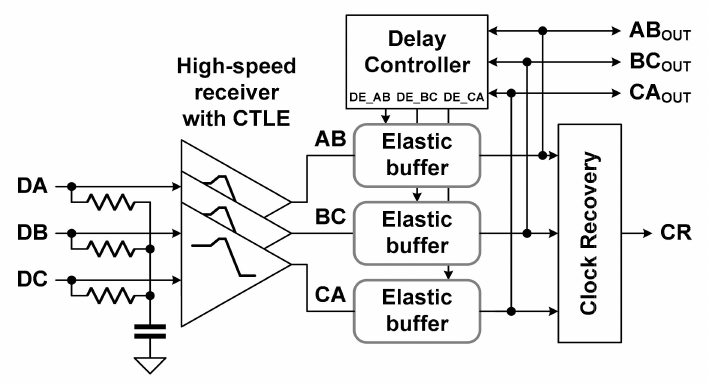
Figure 2. Conventional high-speed receiver using level-dependent elastic buffer for MIPI